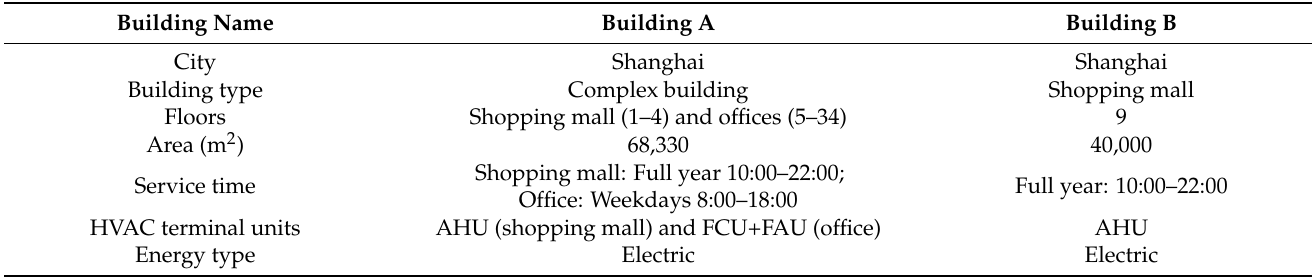
Table 5. Structural information for the two buildings in Shanghai used in this study.